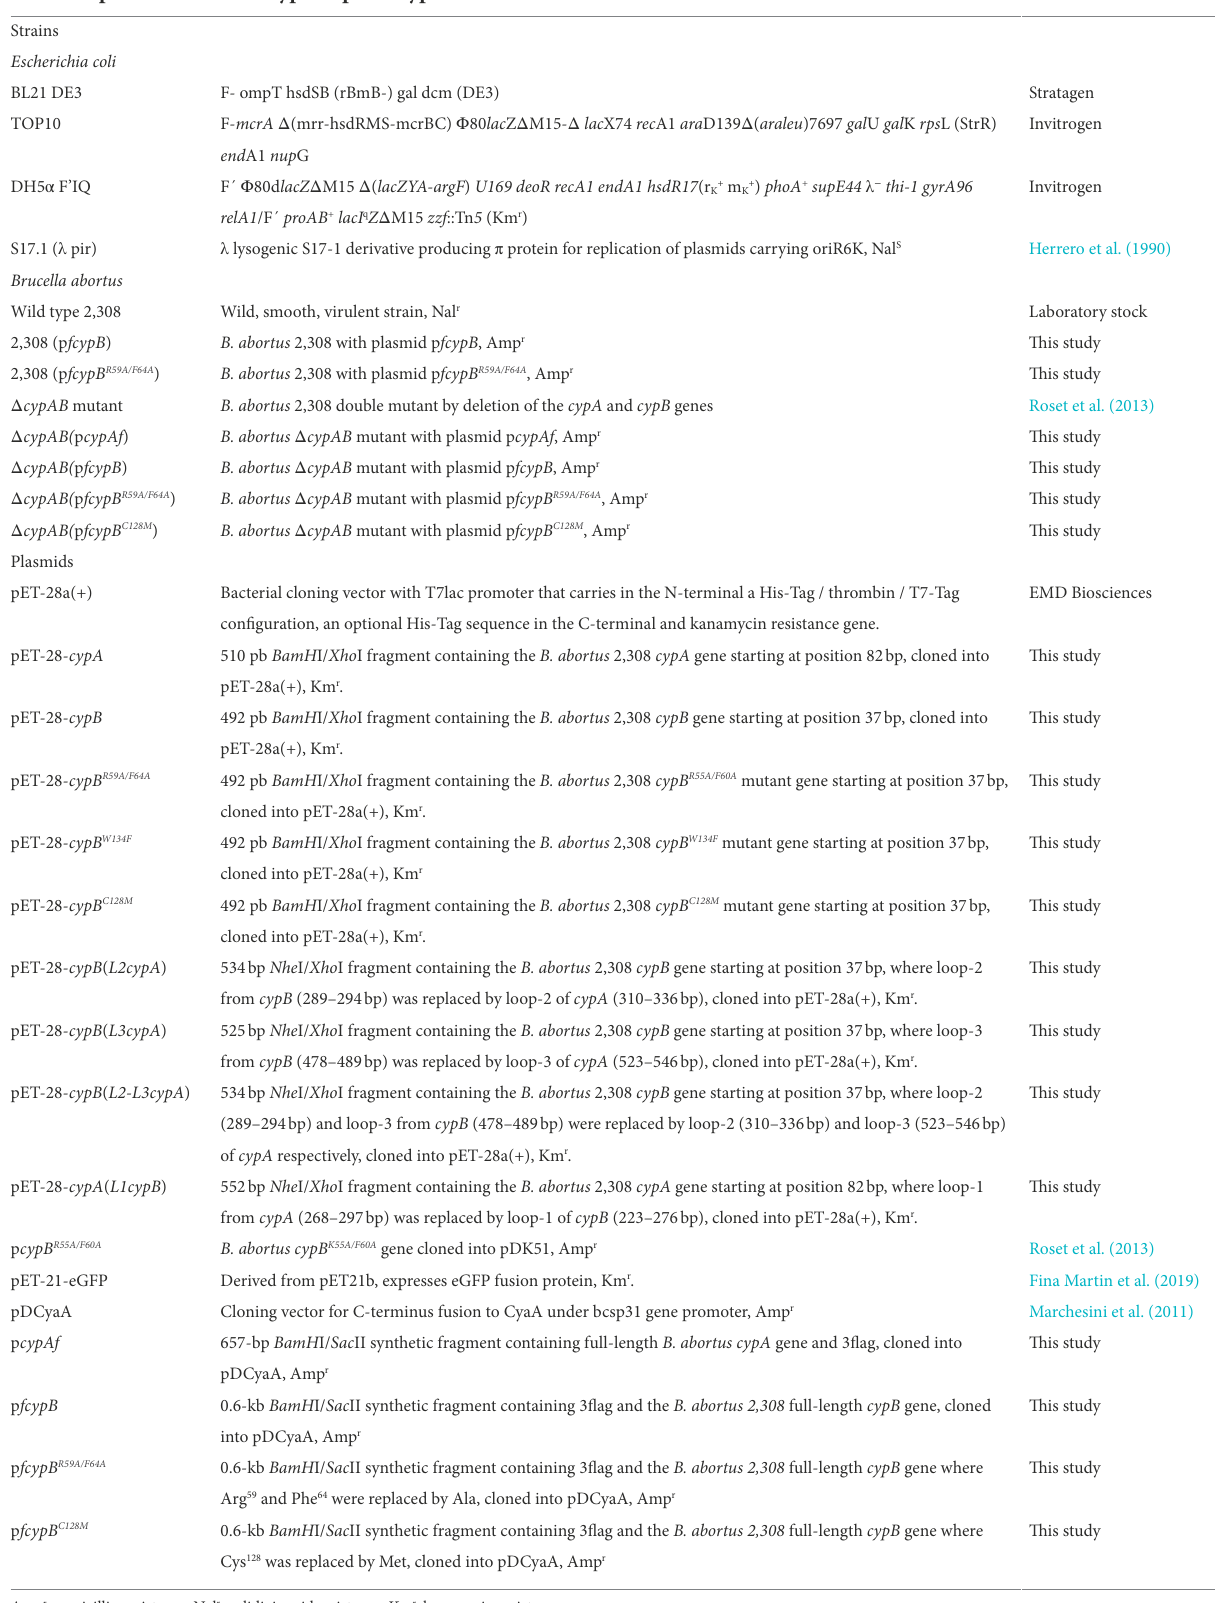
TABLE 1 Bacterial strains and plasmids used in this